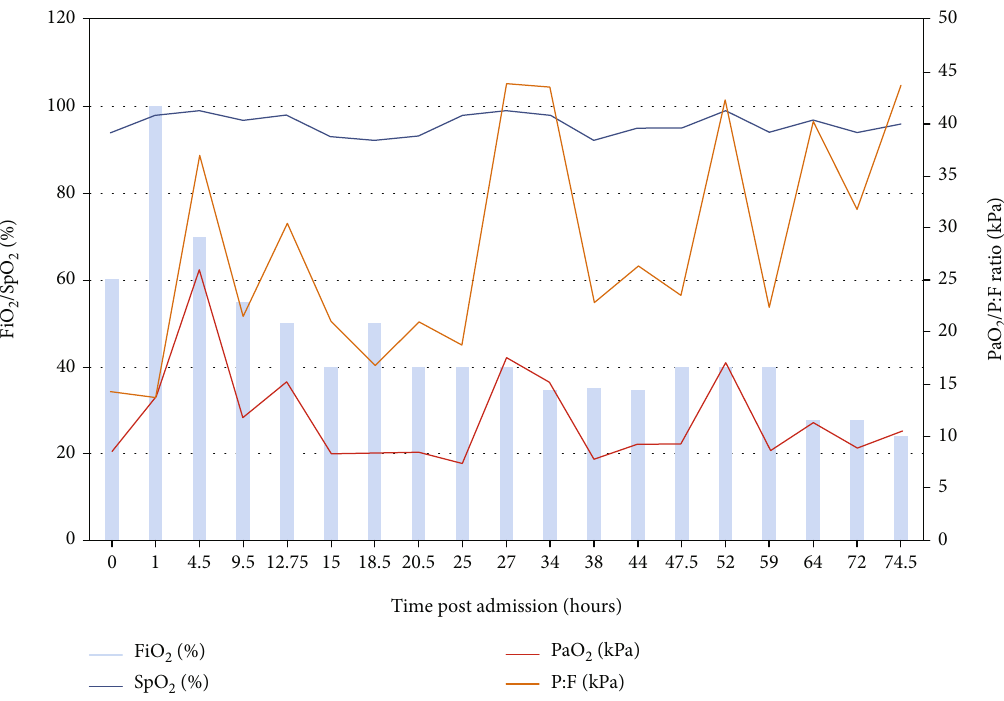
Figure 3: The patient trend in FiO , SpO , PaO , and P:F ratio throughout her time in critical care (P:F 40 kPa = 300mmHg , P:F 26 : 7 kPa 2 2 2 = 200mmHg , and P:F 13 : 3 kPa = 100mmHg ). Self-prone positioning was encouraged when the P:F ratio was under 150 mmHg (20kPa). We did not stipulate a maximum prone time; this was determined by patient comfort, tolerance, and between-care episodes requiring the patient to be